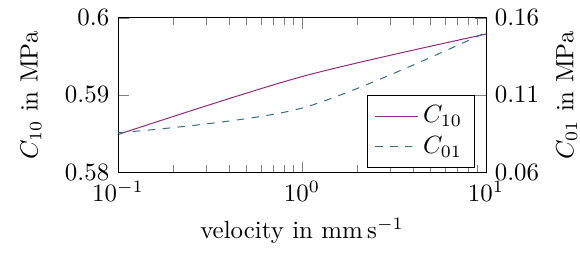
Figure 9. Evolution of C 10 and C 01 over the velocity.